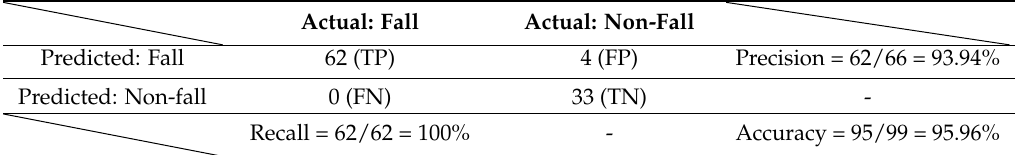
Table 5. Experimental results.